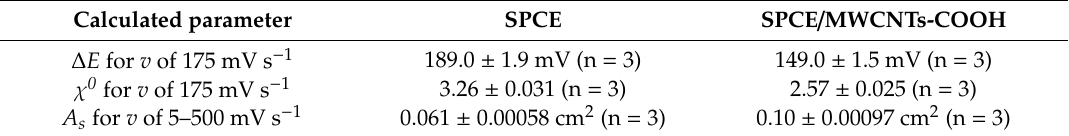
Table 1. Electrochemical characteristics of the SPCE and the SPCE / MWCNTs-COOH using